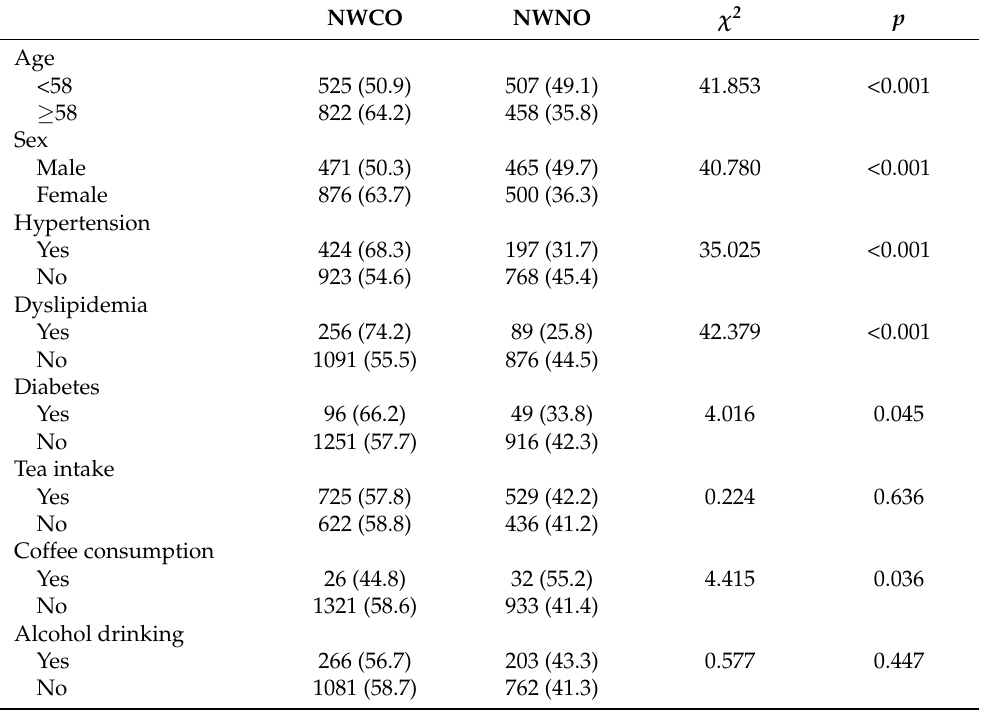
Table 1. Comparison of the prevalence of central obesity in participants under different groups of associated factors (Chi-square test are